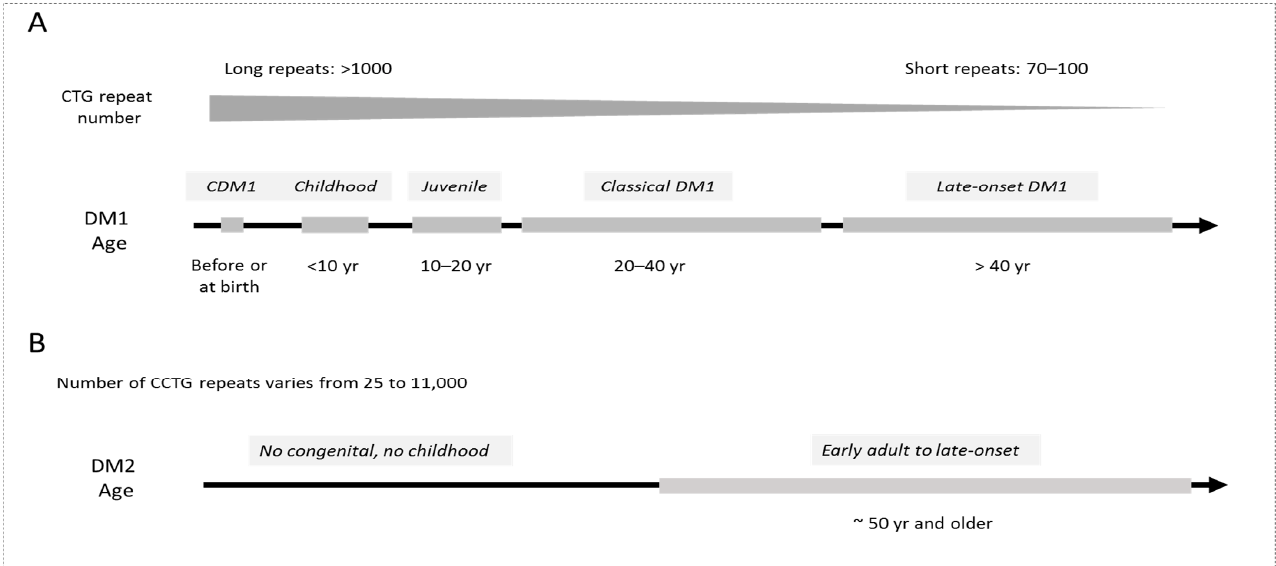
Figure 1. ( A ). Clinical forms of DM1 are shown. The longest CTG expansions are in CDM1 patients. Patients with short CTG repeats are affected later in life with mild symptoms. ( B ). DM2 is an adult disease with vary variable length of CCTG expansions.